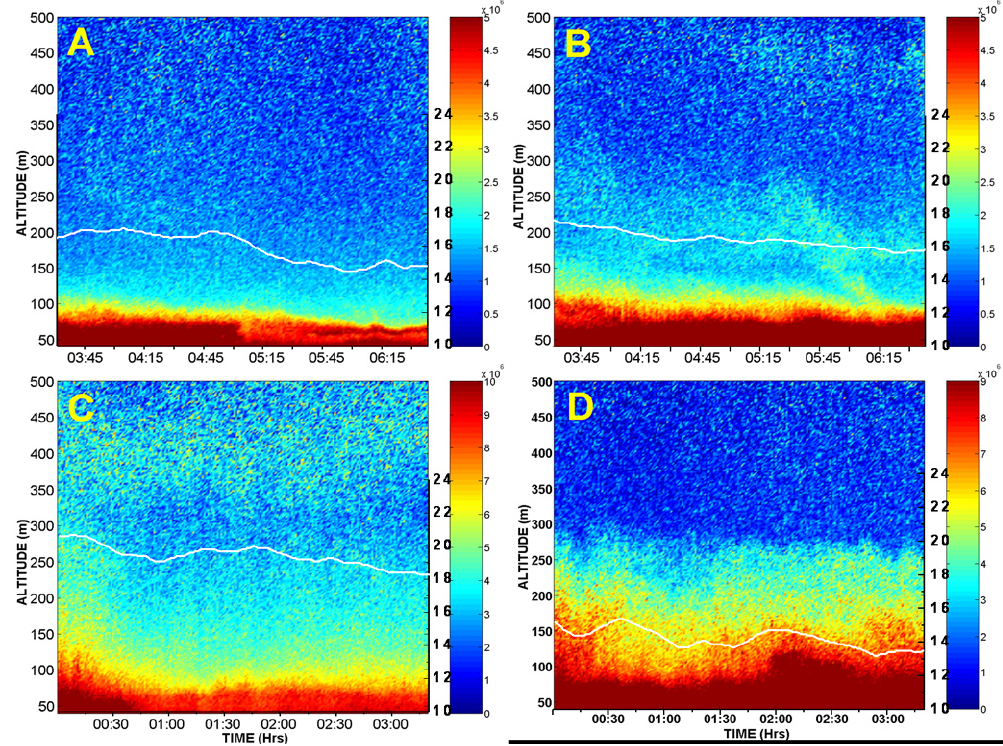
Fig. 1. Height-time-intensity plot of range-square corrected aerosol backscatter signal on (A) 17 January 2008; (B) 14 February 2008; (C) 24 February 2009, and (D) 25 February 2009. The white solid line imposed on all the plots is the time-evolution of corresponding day’s surface